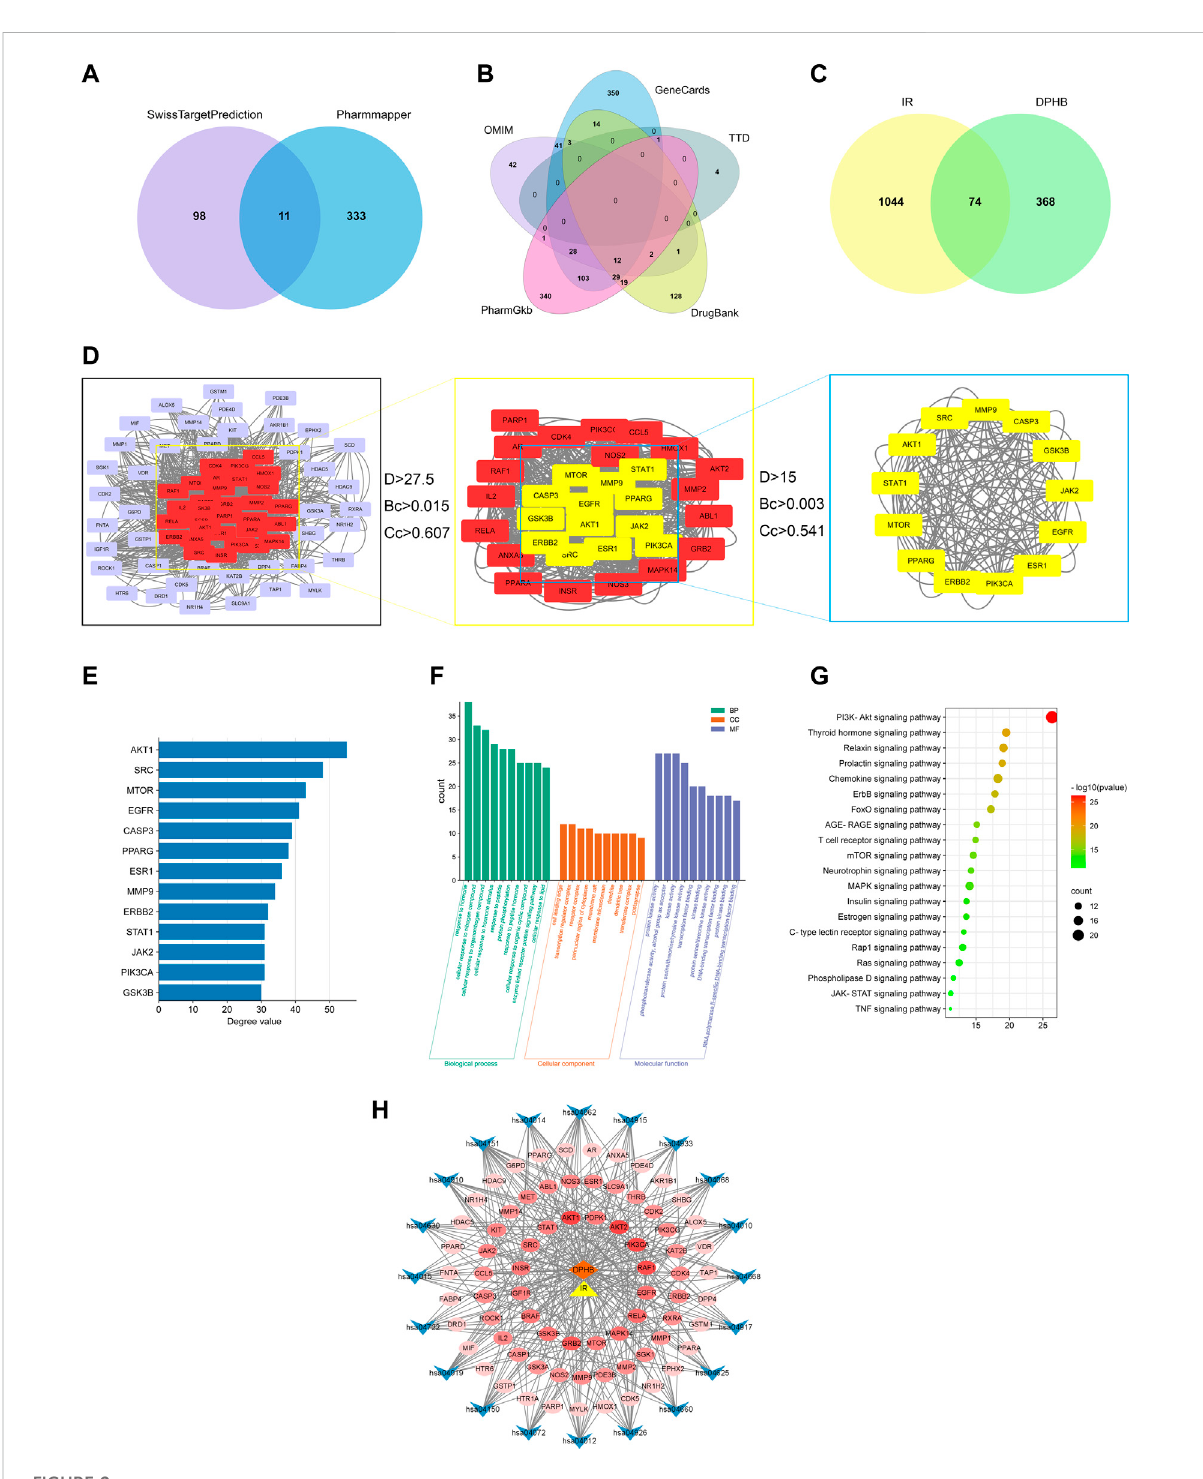
FIGURE 2 Network pharmacology analysis of DPHB on IR. (A) Venn diagram of the DPHB-related targets; (B) Venn diagram of the IR-related targets; (C) Venn diagram of the IR- and DPHB-related targets; (D) PPI network of the potential therapeutic targets; (E) degree value of 13 key nodes; (F) GO enrichment analysis of the targets of DPHB; (G) analysis of KEGG enrichment in 20 pathways as the targets of DPHB; (H) “ component – target – pathway ” of DPHB ameliorating IR. Blue nodes: the KEGG pathway of the KEGG-term identi fi er; red nodes: overlapping genes between DPHB and IR; the redder the color of the node, the higher the degree value of the node; orange node: DPHB; and yellow node: